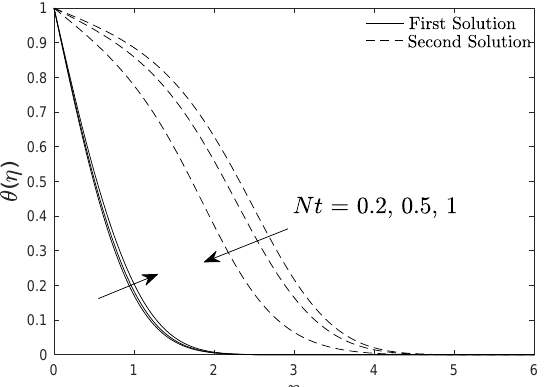
Figure 9. Nanofluid temperature in limiting range of Nt when Le = Pr = 1, Nb = 0.2, γ 1 = 5, γ 2 = 10, M = 0.5 and λ = − 1,1.